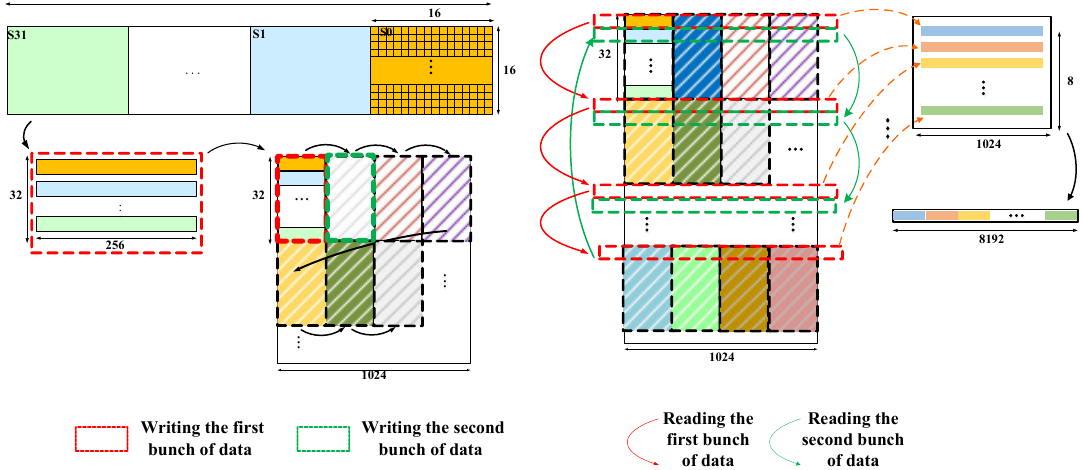
Figure 5. Reading and writing process of matrix transposition.